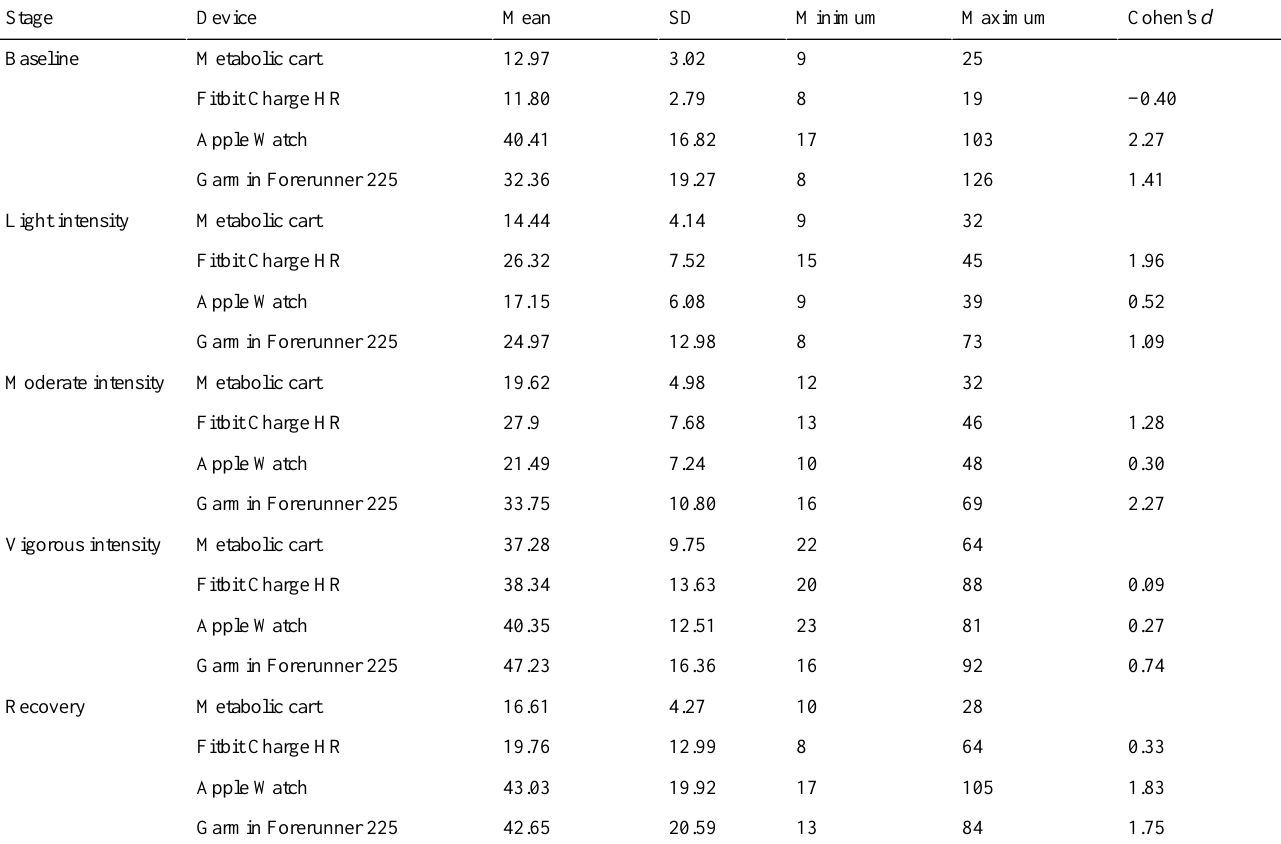
Table 3. Average energy expenditure (kcal) by exercise intensity per